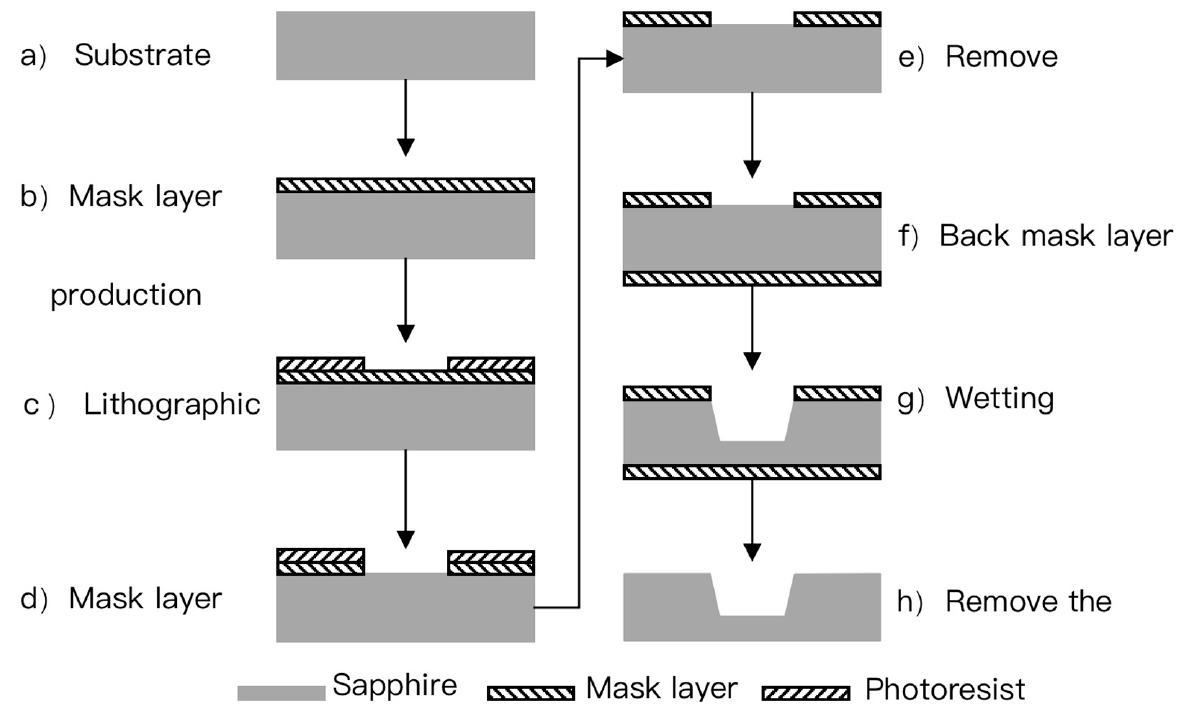
Figure 2. Flow Figure 2. Flow chart.